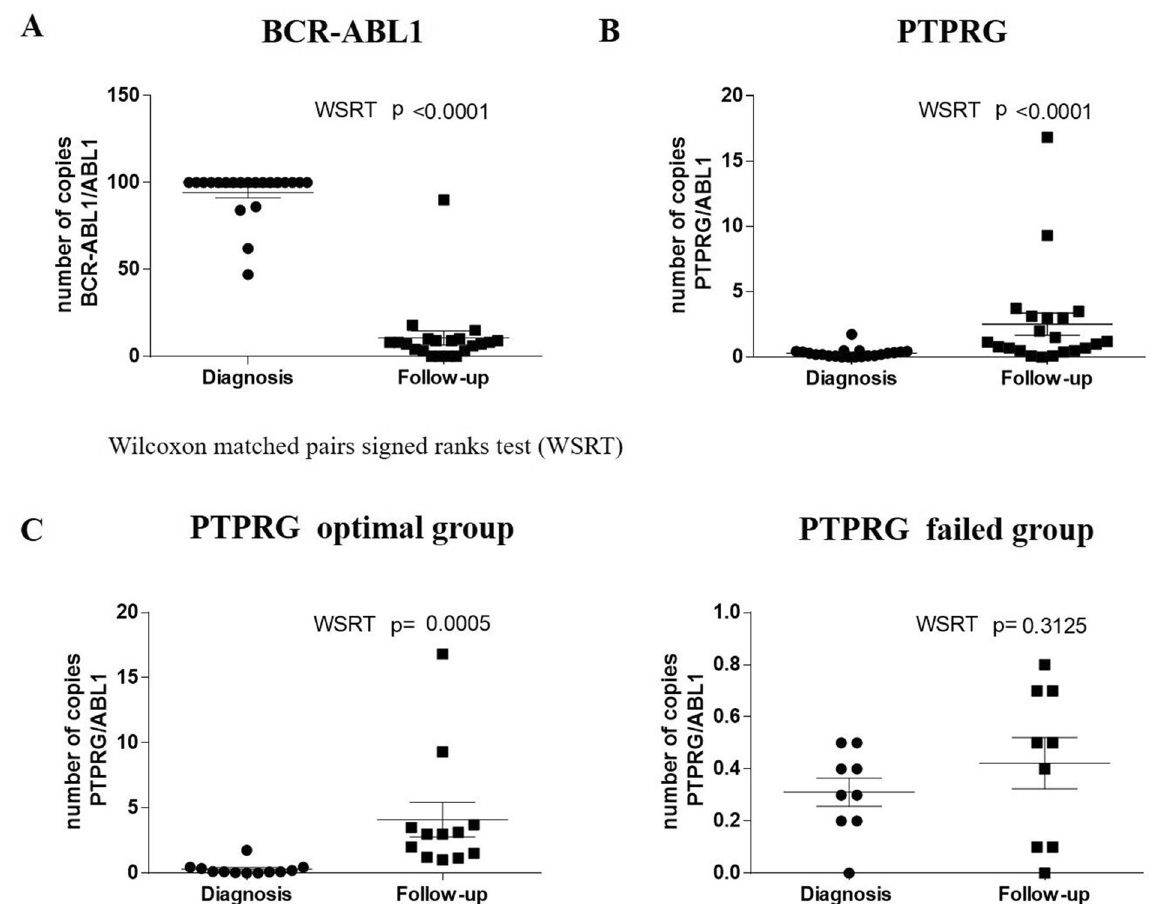
Figure 2. mRNA levels of BCR-ABL1 and PTPRG in CML patients at diagnosis and follow up. ( a ) BCR-ABL1 transcript levels at diagnosis and follow up (mean of post-test ranks = 10 and mean of pre-test ranks = 94.24, Z = − 4.018, p ˂ 0.001). ( b ) PTPRG transcript levels at diagnosis and follow up (mean of post-test ranks = 2.53 and mean of pre-test ranks = 0.3, Z = − 3.50, p ˂ 0.001) ( c ) mRNA transcripts level of PTPRG in the optimal response and failed treatment groups. The mRNA level of PTPRG in the optimal response group was significantly higher when compared with diagnosis, while this significance was lost in the CML group. The Y-axis represents number of PTPRG/ABL1 of mRNA copies, while the X-axis represented timelines at diagnosis and mean of follow up. P values were derived from the WSRT